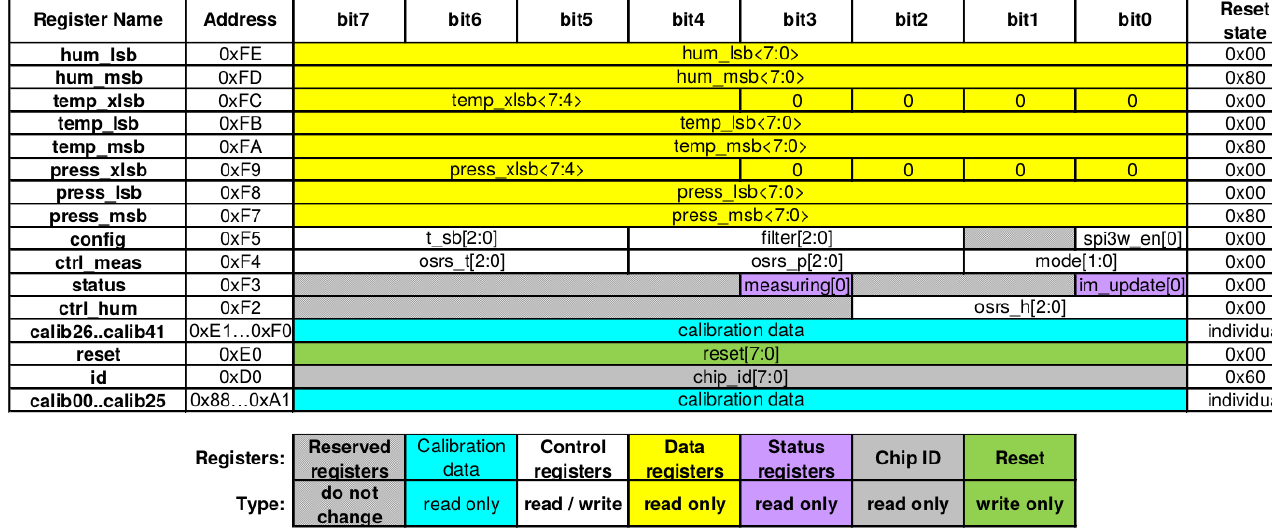
Figure 12. Temperature sensor BME280 memory map [54].